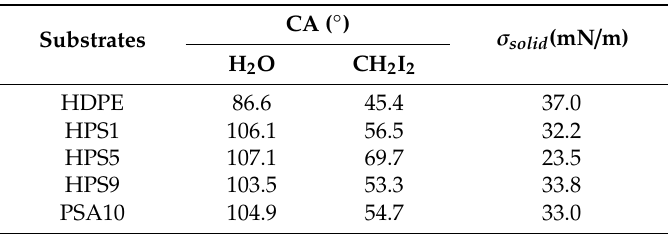
Table 5. Contact angle and surface free energy of di ff erent substrates.